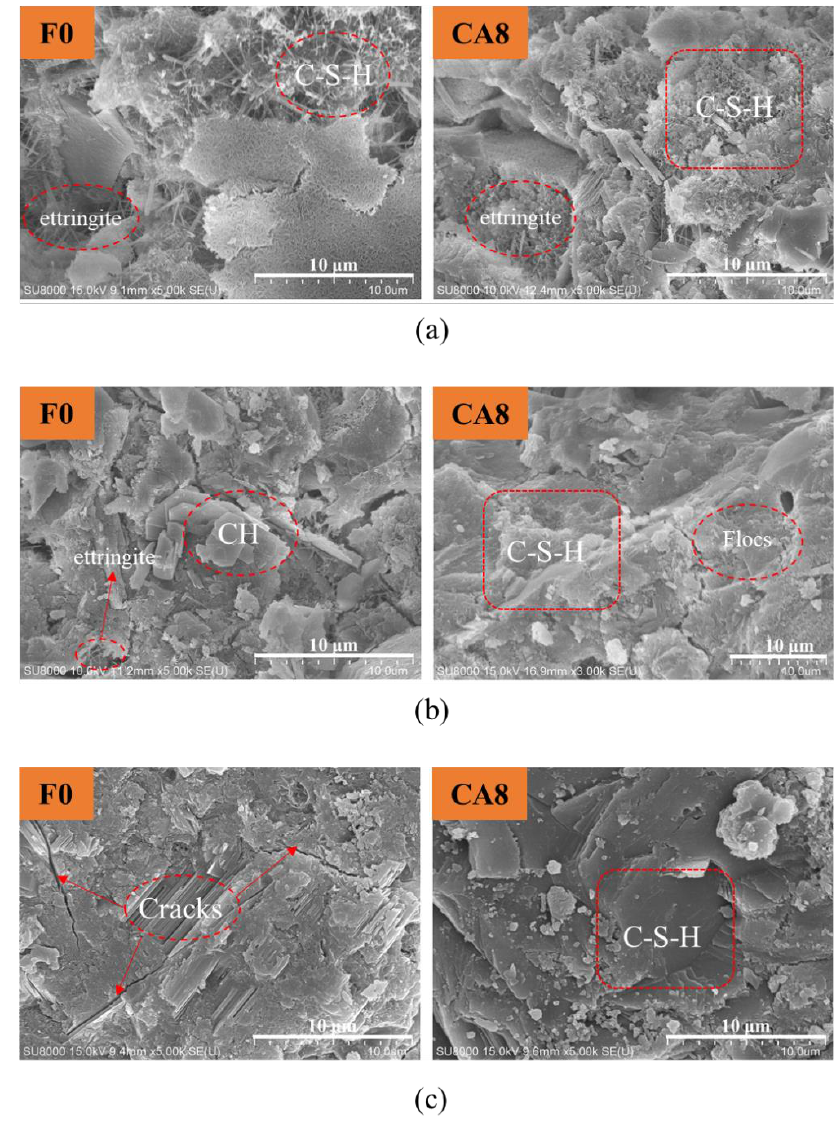
Figure 8. Micromorphology of cement paste at different ages before and after adding calcined attapulgite: ( a ) 3 d; ( b ) 7 d; ( c ) 28 d.